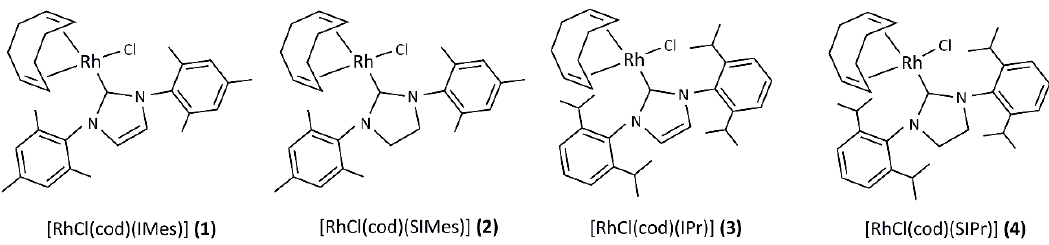
Figure 1. The Rh(I)-NHC complexes 1 – 4 used in our study as catalysts for selective nitrile hydration.